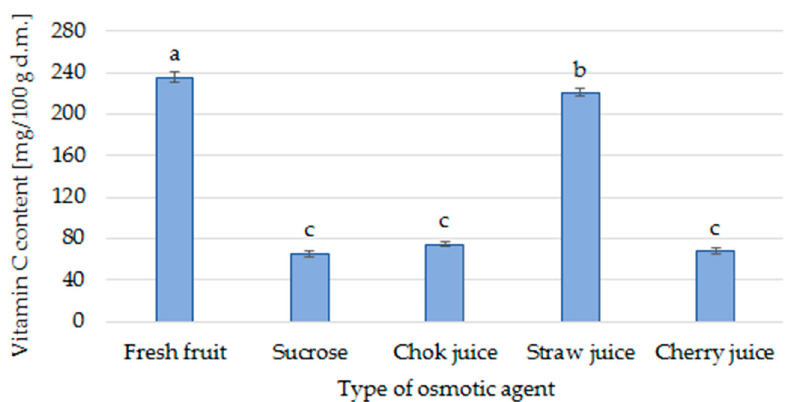
Figure 5. Effect of the type of osmotic agent (sucrose and fruit concentrates) on the vitamin C content in osmodehydrated strawberries. Different letters above columns show the statistical difference ( p <